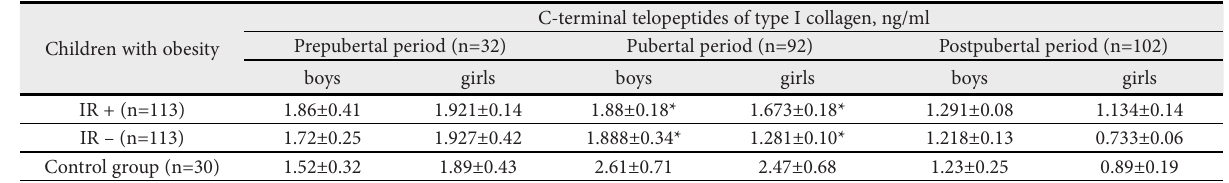
The levels of C-terminal telopeptides of type I collagen in children with obesity